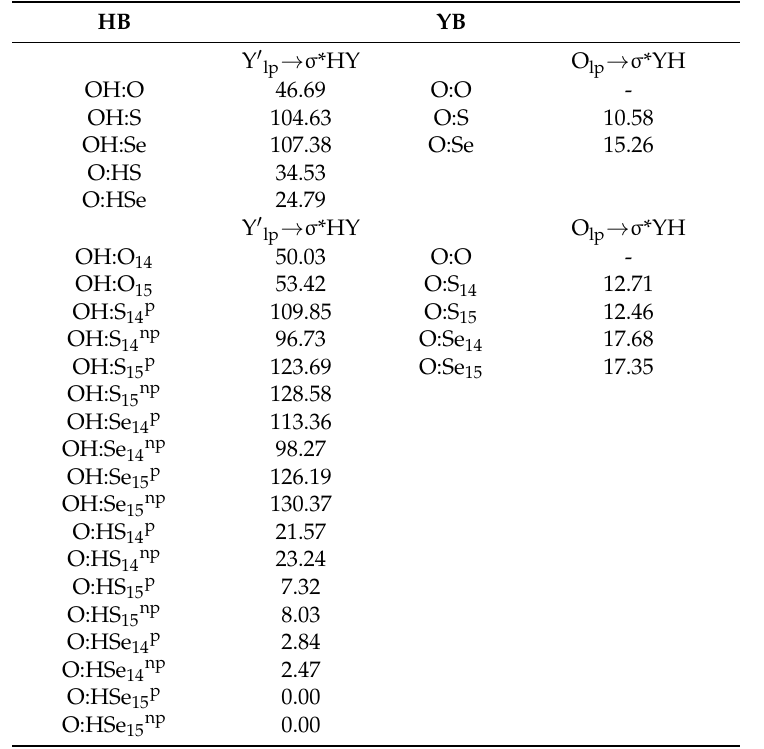
Table 5. Natural Bond Orbital (NBO) stabilization (kJ·mol − 1 ) due to the donation from the chalcogen lone pair (Y ′ lp ) to the antibonding orbital (Y ′ lp → σ *HY) in the hydrogen bonds (HB) systems and O lp → σ *YH in the chalcogen bond (YB) systems.